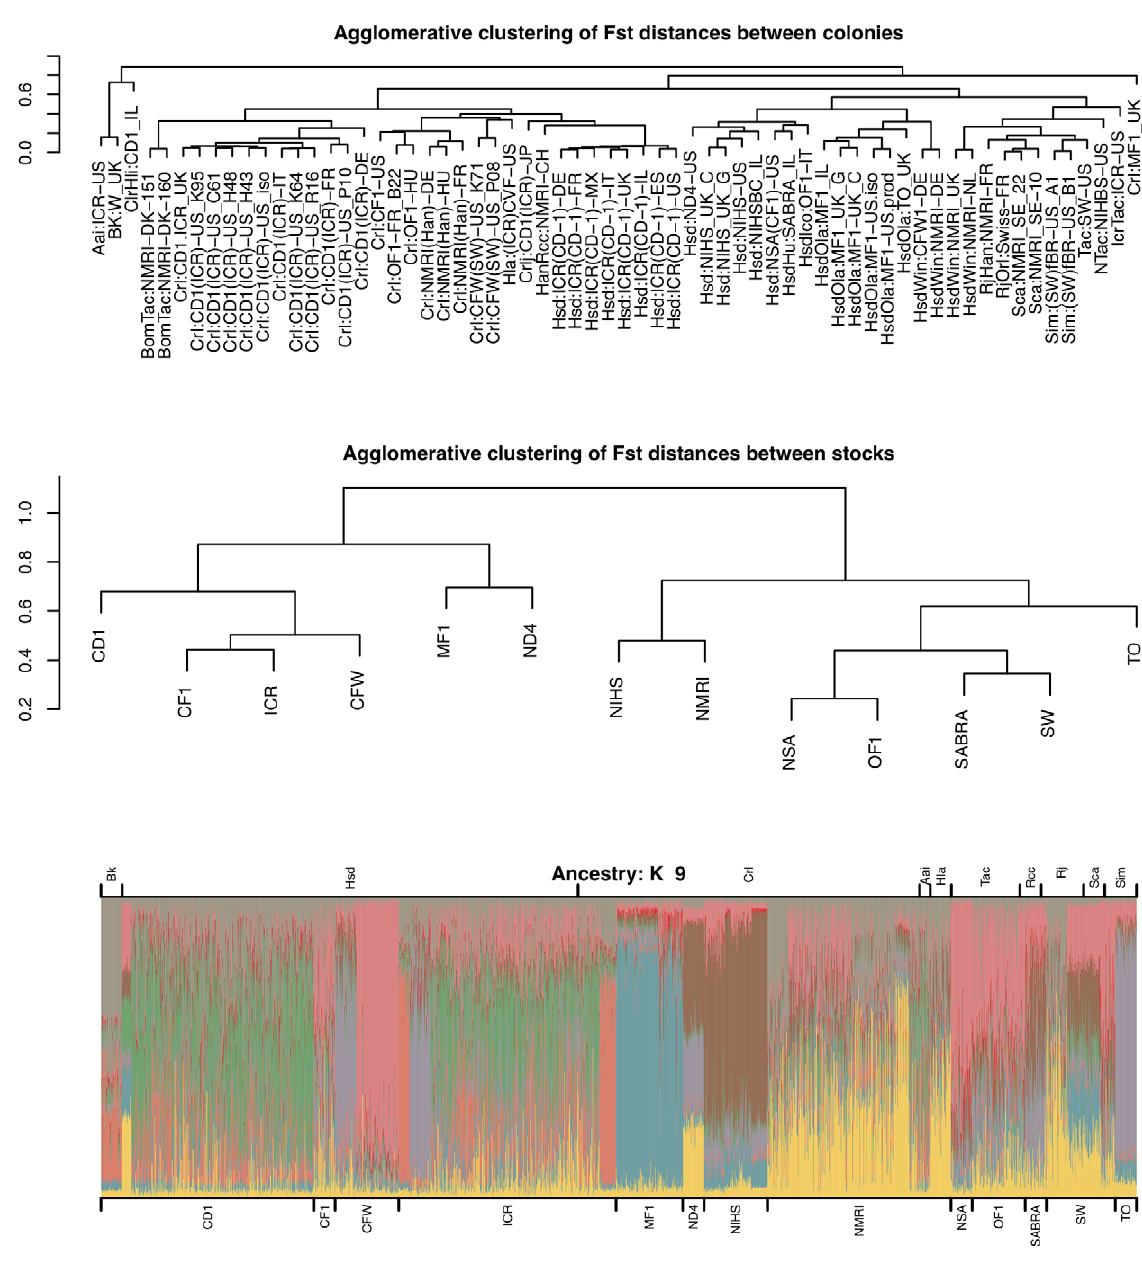
Figure 4. Colonies, stocks, and ancestry. Top two panels: relationship between colonies (top) and stocks (middle panel) shown by agglomerative clustering of Fst distances. Bottom panel: ancestry inferred from the FRAPPE program at K=9. The length of each colored corresponds to the ancestry coefficient of each mouse, plotted along the horizontal axis. Mice are labeled by stock name (along the bottom) and by commercial provider along the top. Mice of the same colony were grouped together (giving rise to blocks of common ancestry, as seen for example to the right of the CD1 cluster) but individual colony labels omitted.